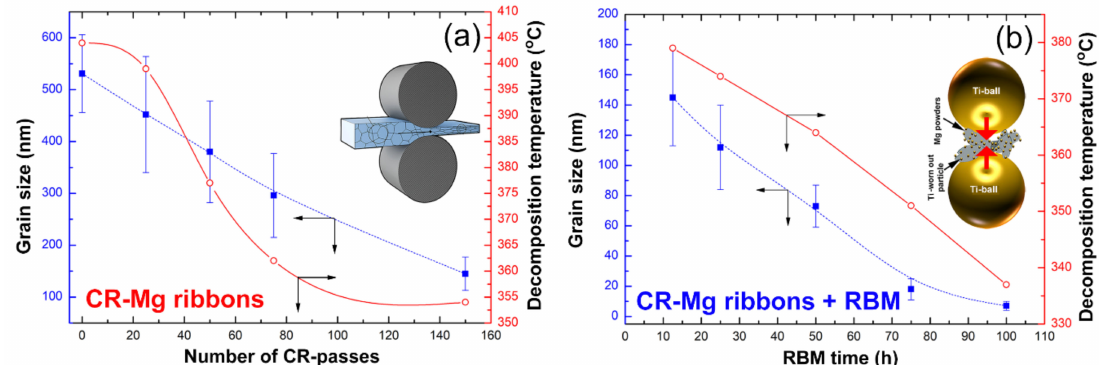
Figure 12. Correlations between processing approaches, grain sizes, and decomposition temperature for MgH 2 prepared through ( a ) CR, and ( b ) CR + RBM